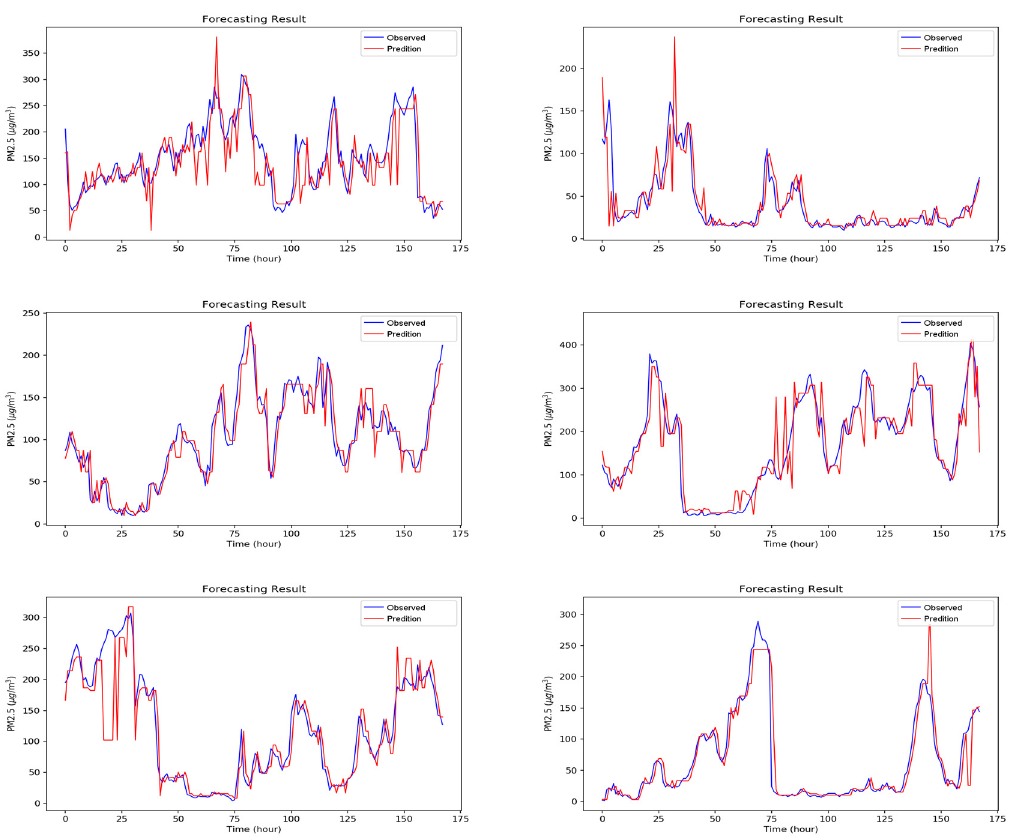
Figure A3. The forecasting results of decision tree.